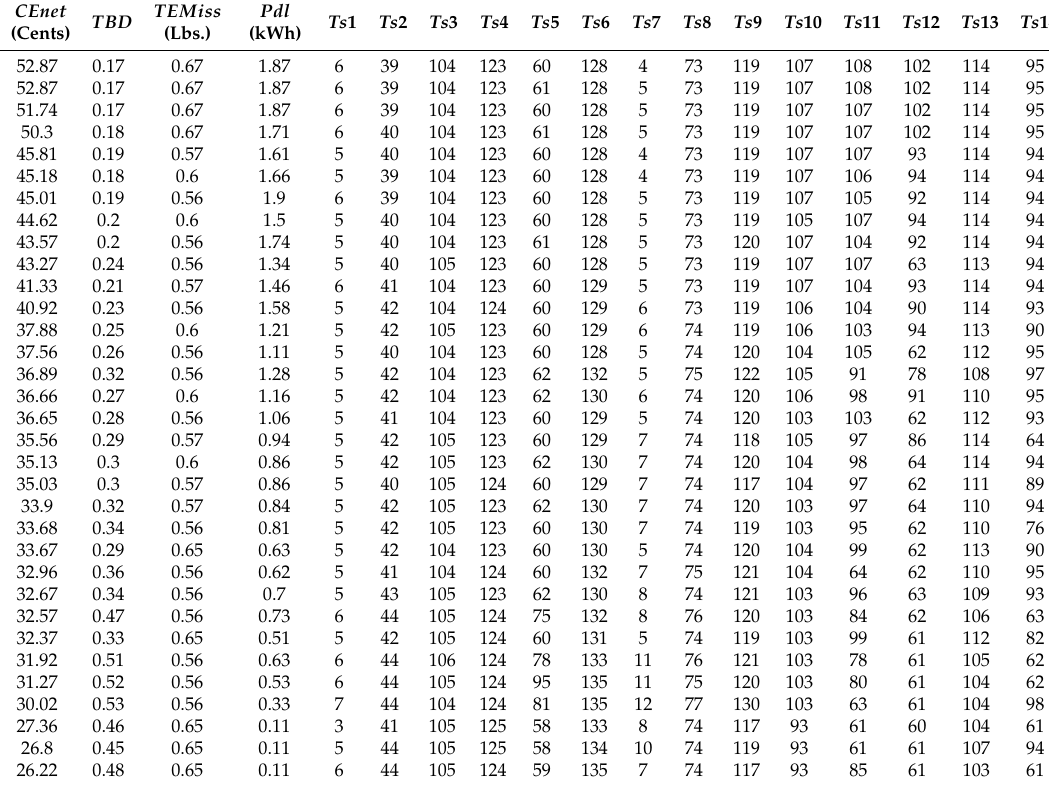
Table 13. Eco-efficient solutions for DRSREODLDG-BASED HEMS using Algorithm 2 (Step-3). CEnet TEMiss TBD (Cents)